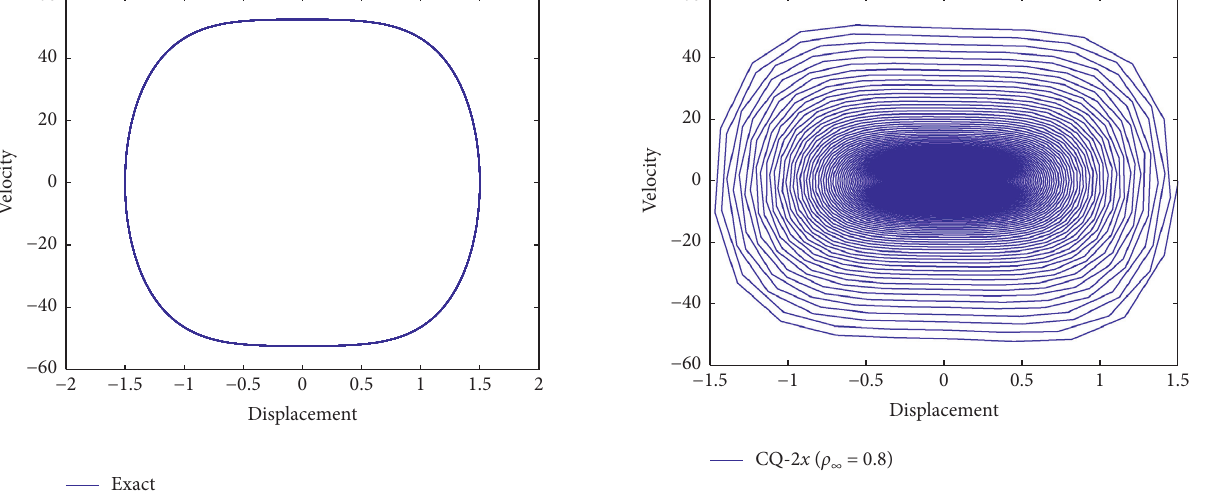
Figure 13: Exact solution for the phase portrait of the hardening spring.